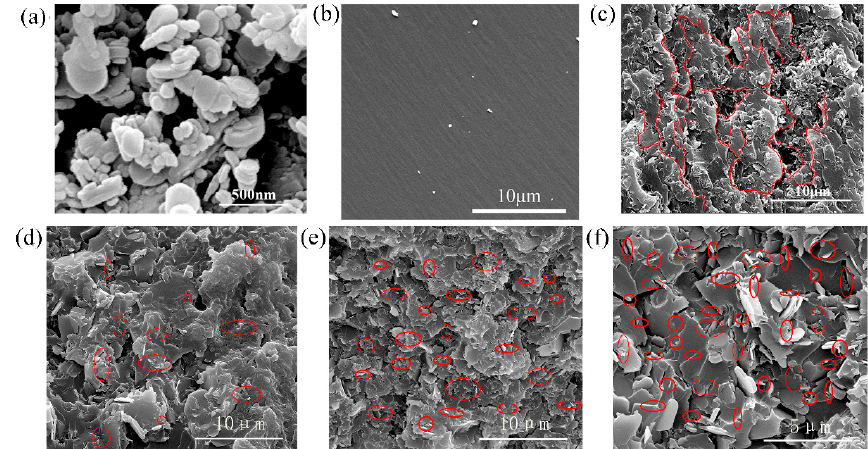
Figure 5. Fractural images of h-BN/ f -CNT reinforced composites: ( a ) pristine h-BN; ( b ) pristine resin matrix; ( c ) resin matrix with h-BN (40 wt%); ( d ) resin matrix with both h-BN (40 wt%) and f -CNTs (0.3 wt%); ( e ) resin matrix with both h-BN (40 wt%) and f -CNTs (0.4 wt%), and ( f ) resin matrix with both h-BN (40 wt%) and f -CNTs (0.5 wt%).